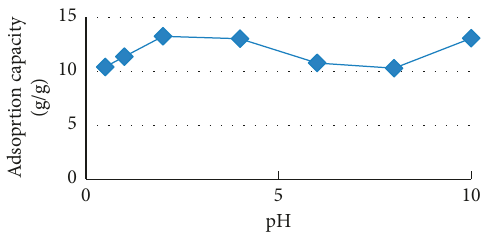
Figure 4: Effect of initial pH.